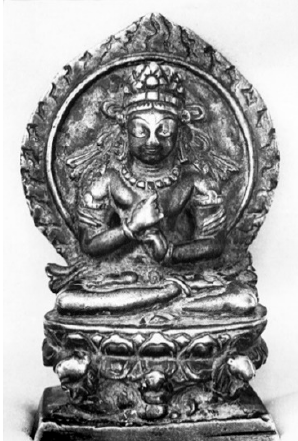
Figure 26. Mah ā vairocana in sambhogak ā ya form performing the bodhy ā gr ī mudr ā , eighth c. Kashmir. Brass. Sri Pratap Singh Museum, Srinagar, Kashmir. Photograph from Pal, Bronzes of Kashmir , pl. 37.